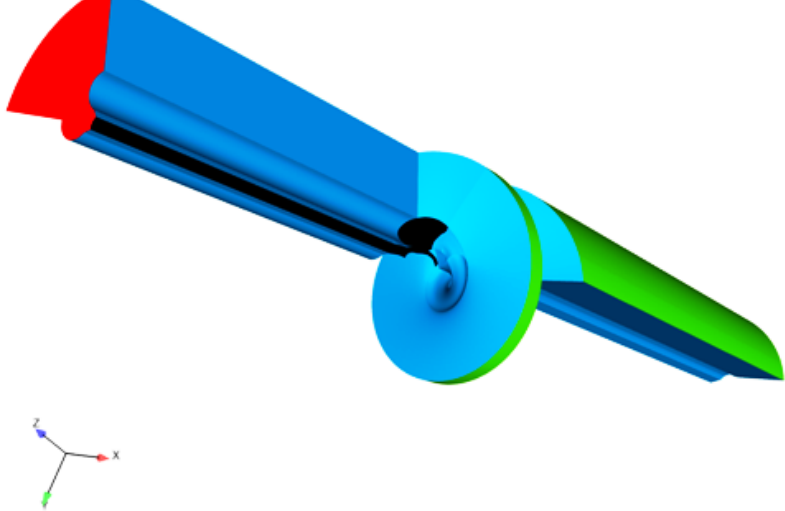
Figure 3. A perspective view of the grid topology used in the open-water